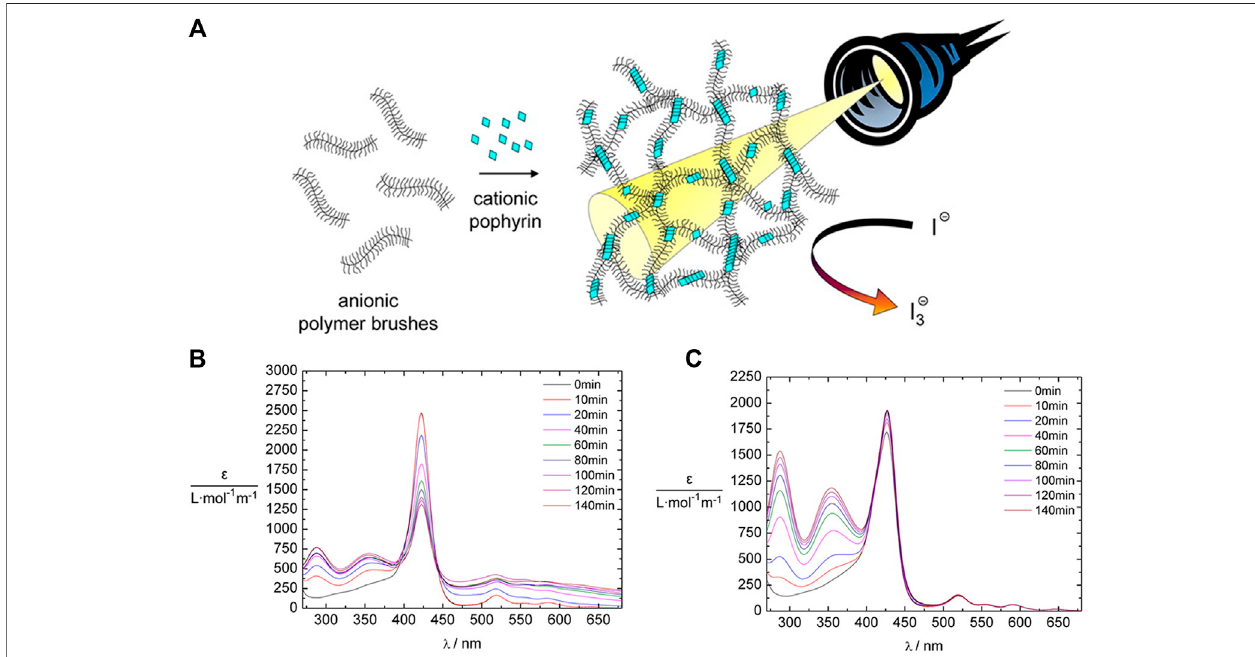
FIGURE 27 | Polyelectrolyte brush-porphyrin assemblies as photocatalysts: (A) Scheme, and UV/Vis absorption spectra in dependence on irradiation time for catalyzing the iodide oxidation as the model reaction: (B) TMPyP without polyelectrolyte and (C) a TMPyP/PSS brush sample; The bands at λ (cid:1) 353 nm and at λ (cid:1) 287 nm indicate the faster tri-iodide formation with the nano-assembly as the catalyst (Frühbeißer and Gröhn, 2012). Reprinted with permission. Copyright © 2012 American Chemical Society.